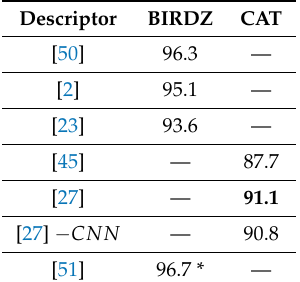
Table 4. Literature